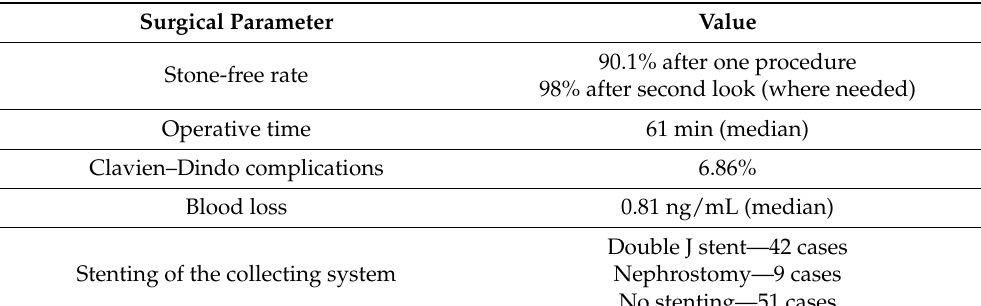
Table 2. Overview of surgical parameters in our